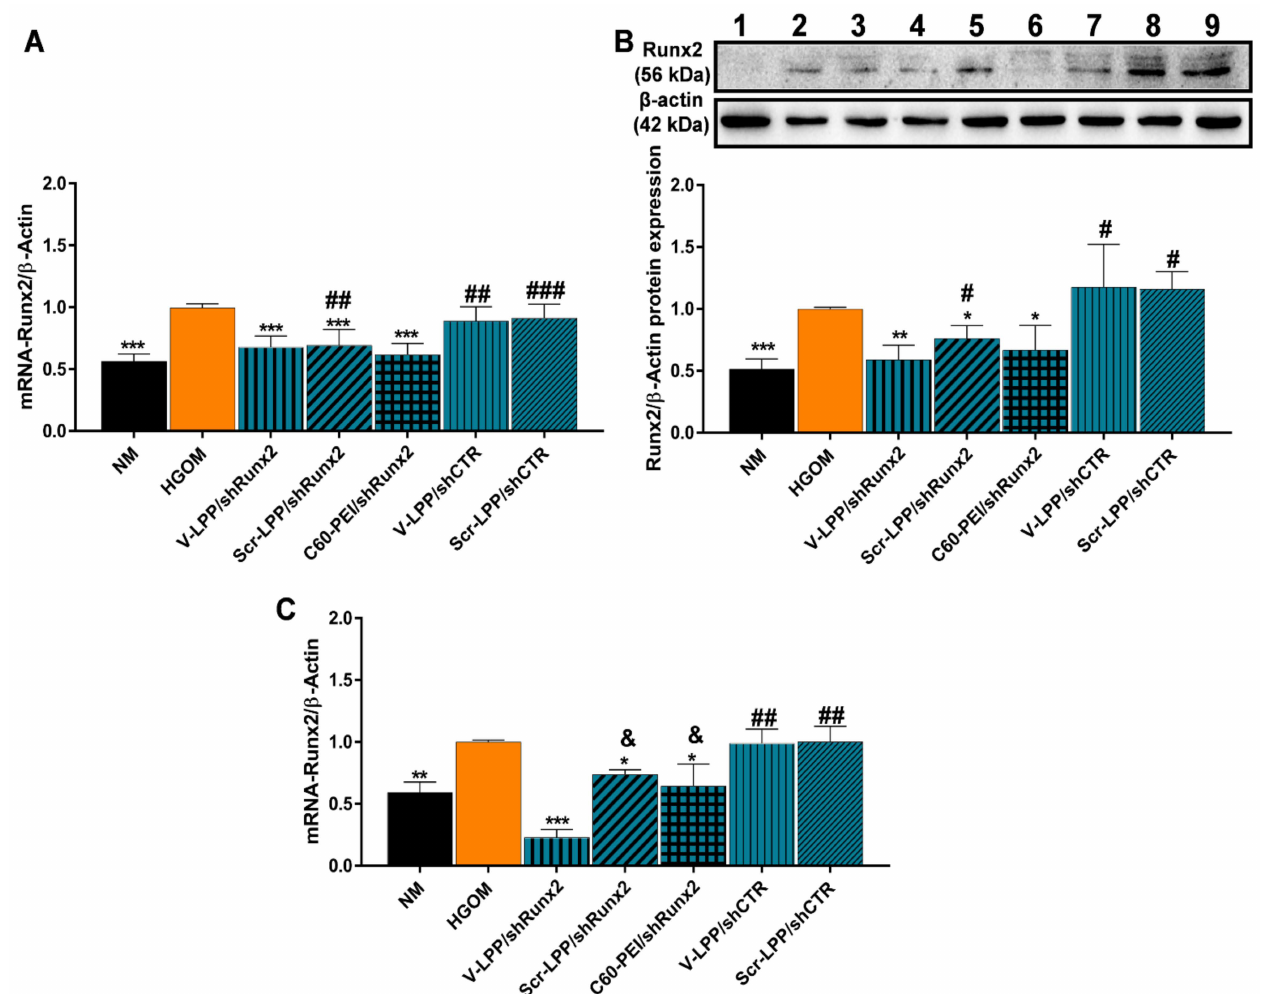
Figure 5. Downregulation of Runx2 expression in osteoblast-differentiated VIC. ( A ) mRNA and ( B ) protein Runx2 expression in HGOM-activated VIC for 5 days and transfected for 48 h with different type of nanocarriers. NM (lane 1); HGOM (lane 2); V-LPP/shRunx2 (lanes 3, 4); Scr-LPP/shRunx2 (lane 5); C60-PEI/shRunx2 (lane 6); V-LPP/shCTR (lanes 7, 8); Scr-LPP/shCTR (lane 9). ( C ) mRNA Runx2 level in HGOM-activated VIC subjected to double transfection in the 5th and 12th days, and measured 48 h after the second transfection (14th day). The results were normalized to β -actin and represent the mean ± S.D. of two independent experiments made in duplicate ( n = 4) and represent fold change relative to HGOM condition (considered as 1). The samples considered statistically different were marked with * p < 0.05, ** p < 0.01, *** p < 0.001 when compared to HGOM; # p < 0.05, ## p < 0.01, ### p < 0.001 when compared to NM; & p <0.05 when compared to